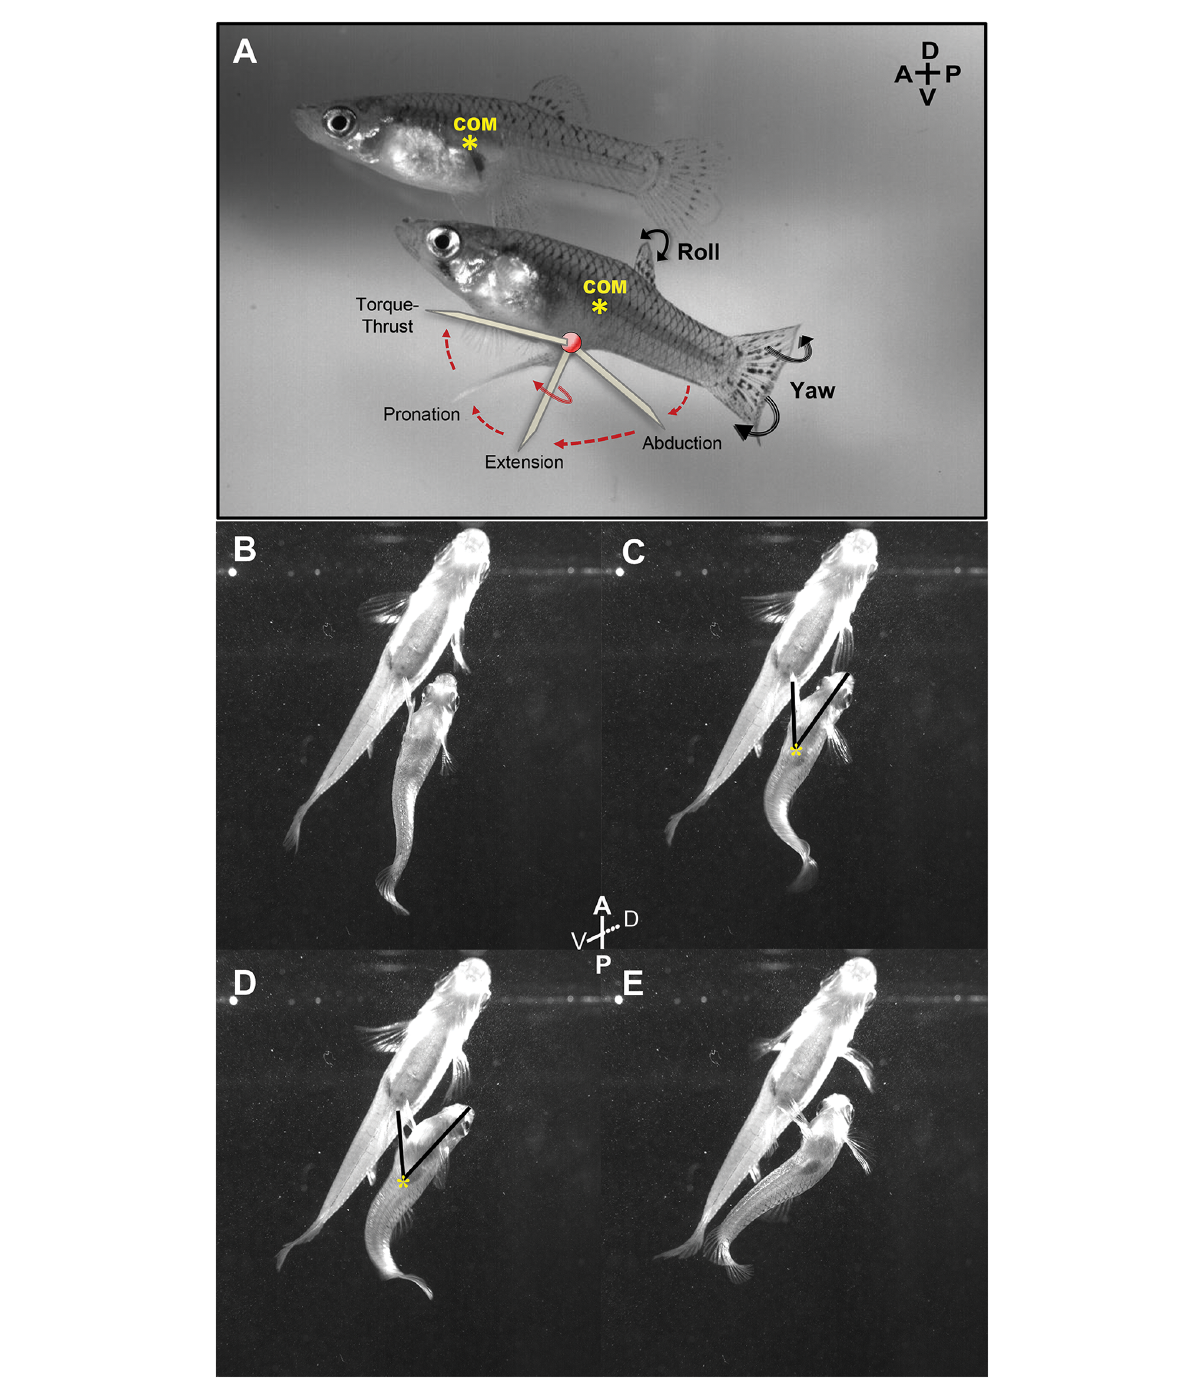
FIGURE4 Lateral and ventral view of an adult male mosquitofish performing circumduction of the gonopodium. (A) Diagram shows all the gonopodial positions during circumduction (abduction, extension, rotation, and torque-thrust; each identified as diagonal lines). Center of mass (COM; yellow asterisk) was calculated in adult female mosquitofish to compare the localization with the COM in adult male mosquitofish. We observed the same localization of COM across all females recorded. Female COM was calculated anterior to the anal fin, very close to the gravid spot and the swim bladder, while male COM was more posteriorly positioned, dorsal to the gonopodium (see details in methods for analysis of mating kinematics). Ventral view of an adult male mosquitofish performing Torque (B,C) and Thrust (D,E) maneuvers of gonopodial circumduction with intact superficial neuromasts at the base of the gonopodium. Note that the tip of the gonopodium is in the closest position to the female genitalia